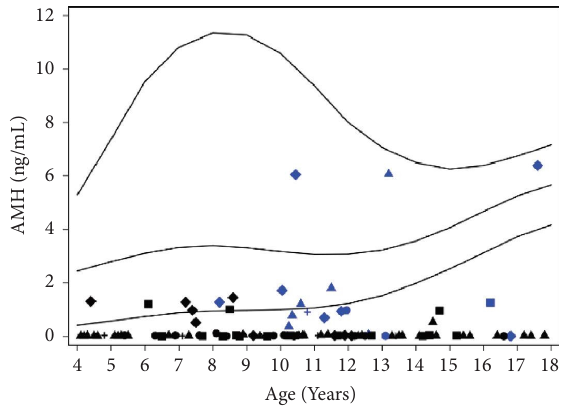
Figure 1: Serum AMH levels in TS adolescent girls with spontaneous puberty. Te reference range is based on healthy Chinese girls. Lines represent the median, the 2.5 th percentile, and the 97.5 th percentile. Serum concentrations of AMH (ng/ml) of 95 TS patients are plotted versus age. Triangles: 45, X; diamond: mosaicism; squares: mosaicism with SCA; circle: SCA; cruciform: with Y chromosome; black: TS patients with nonspontaneous puberty; blue: TS patients with spon- taneous puberty. pmol/L � ng/mL ∗